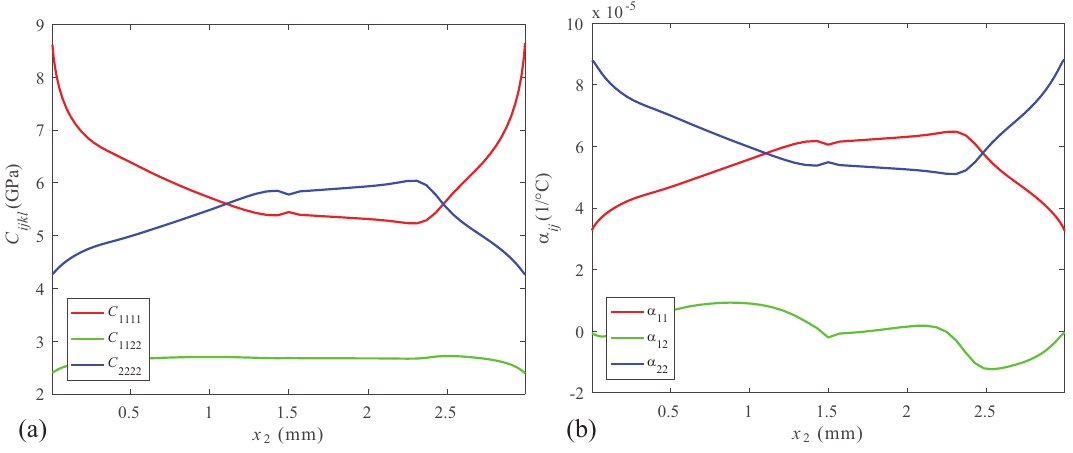
Figure 10. Results in the deposited bead from the IRD-RSC model with C I = 10 − 2 and κ = 1/30. (cid:68) (cid:69) C ijkl ( a ) as a function of x 2 in the deposited bead, and ( b )